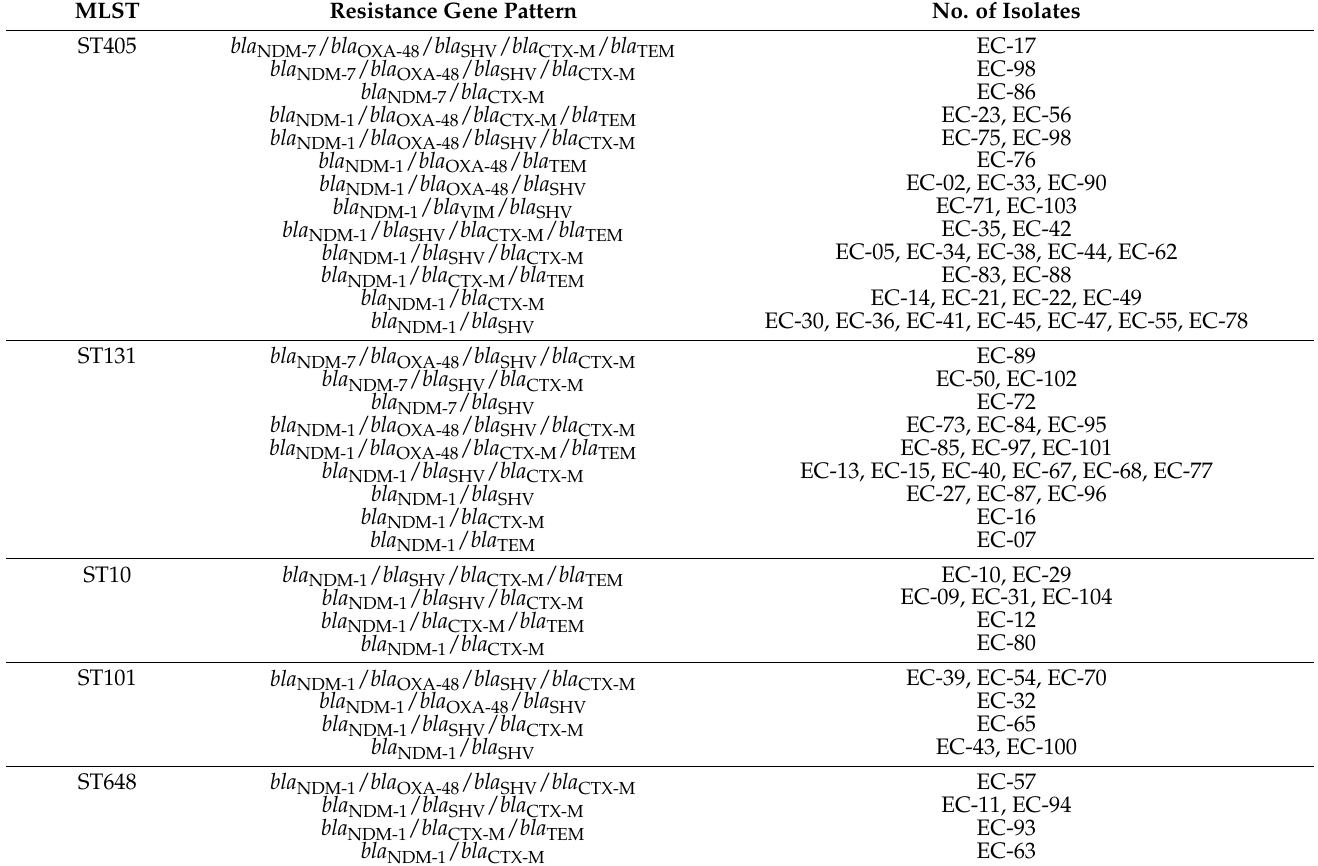
Table 3. Distribution of sequence types with resistance gene